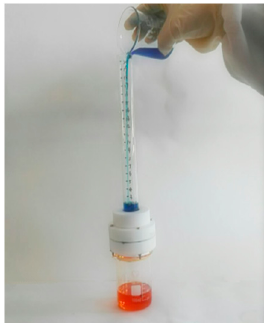
Figure 11. Oil-water separation device.